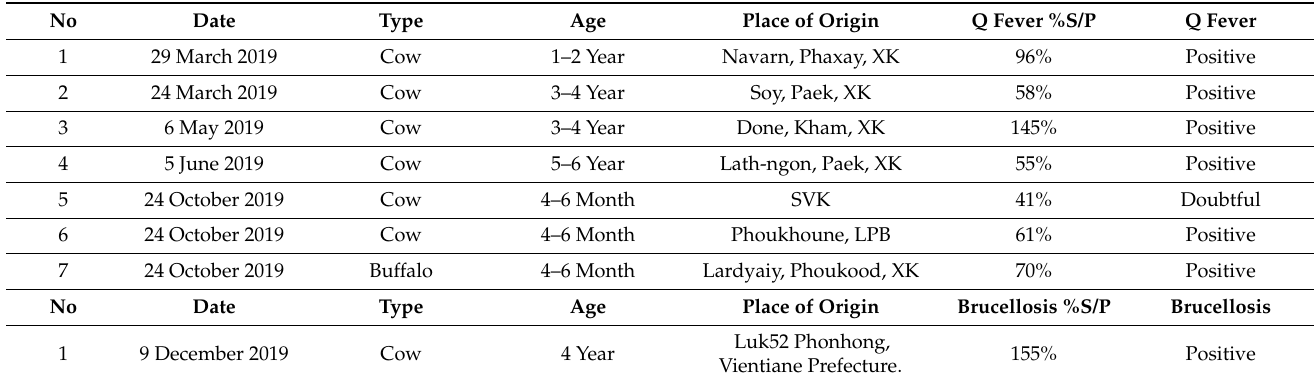
Table 1. Q Fever and brucellosis Ab ELISA results.